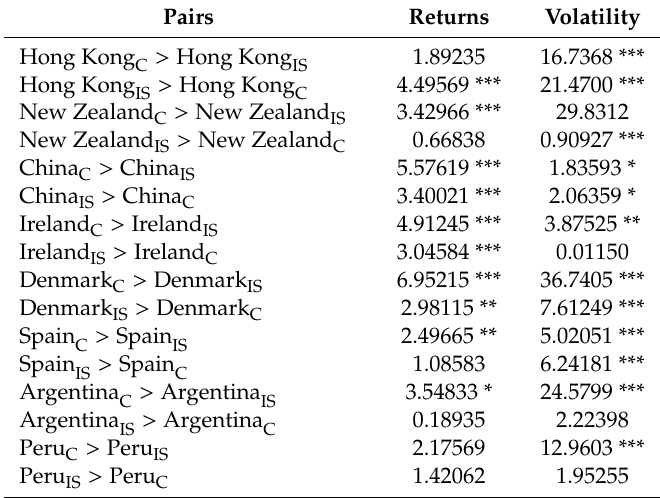
Table 6. Granger Causality Results for Islamic and Conventional Stock Returns and